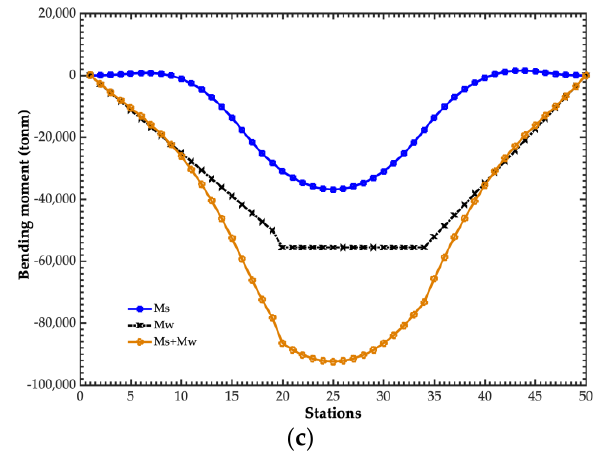
Figure 12. Results of Q S(x ) , M S(x) and M W along barge for the 7000-ton load conditions: ( a ) shear forces, ( b ) sagging bending moments, and ( c ) hogging bending moments.